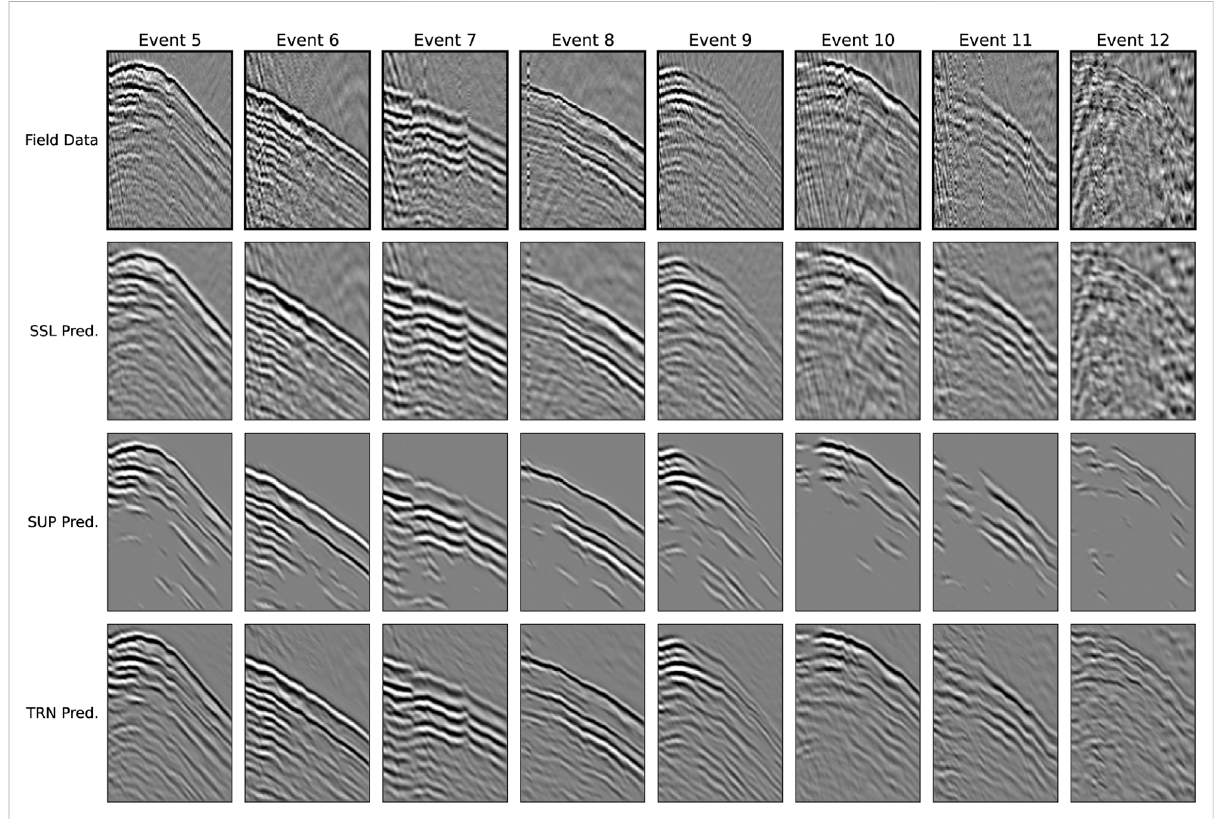
FIGURE 9 Additional comparison of denoising performances on fi eld data. The top row portrays the raw fi eld data whilst the remaining three rows represent the denoised products from the self-supervised network, supervised network, and transferred network,